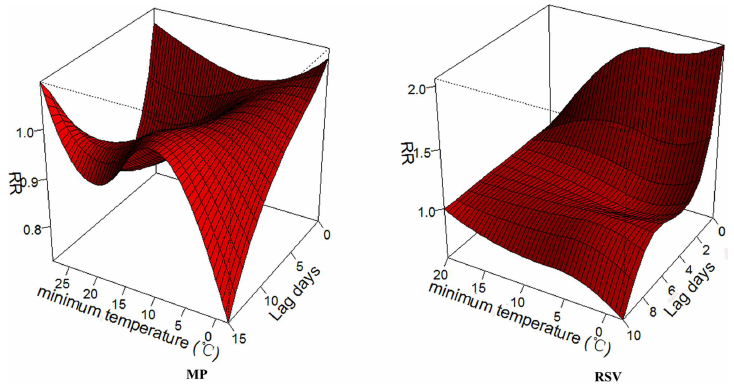
Fig 4. Lag associations and dose effect between temperature (baseline: 20˚C) and MP and RSV infection rates using the DLNM model and controlling for holiday effects, relative humidity, day of the week and long-term trends. Temperature had evident lag on the RSV infectionrate and MP